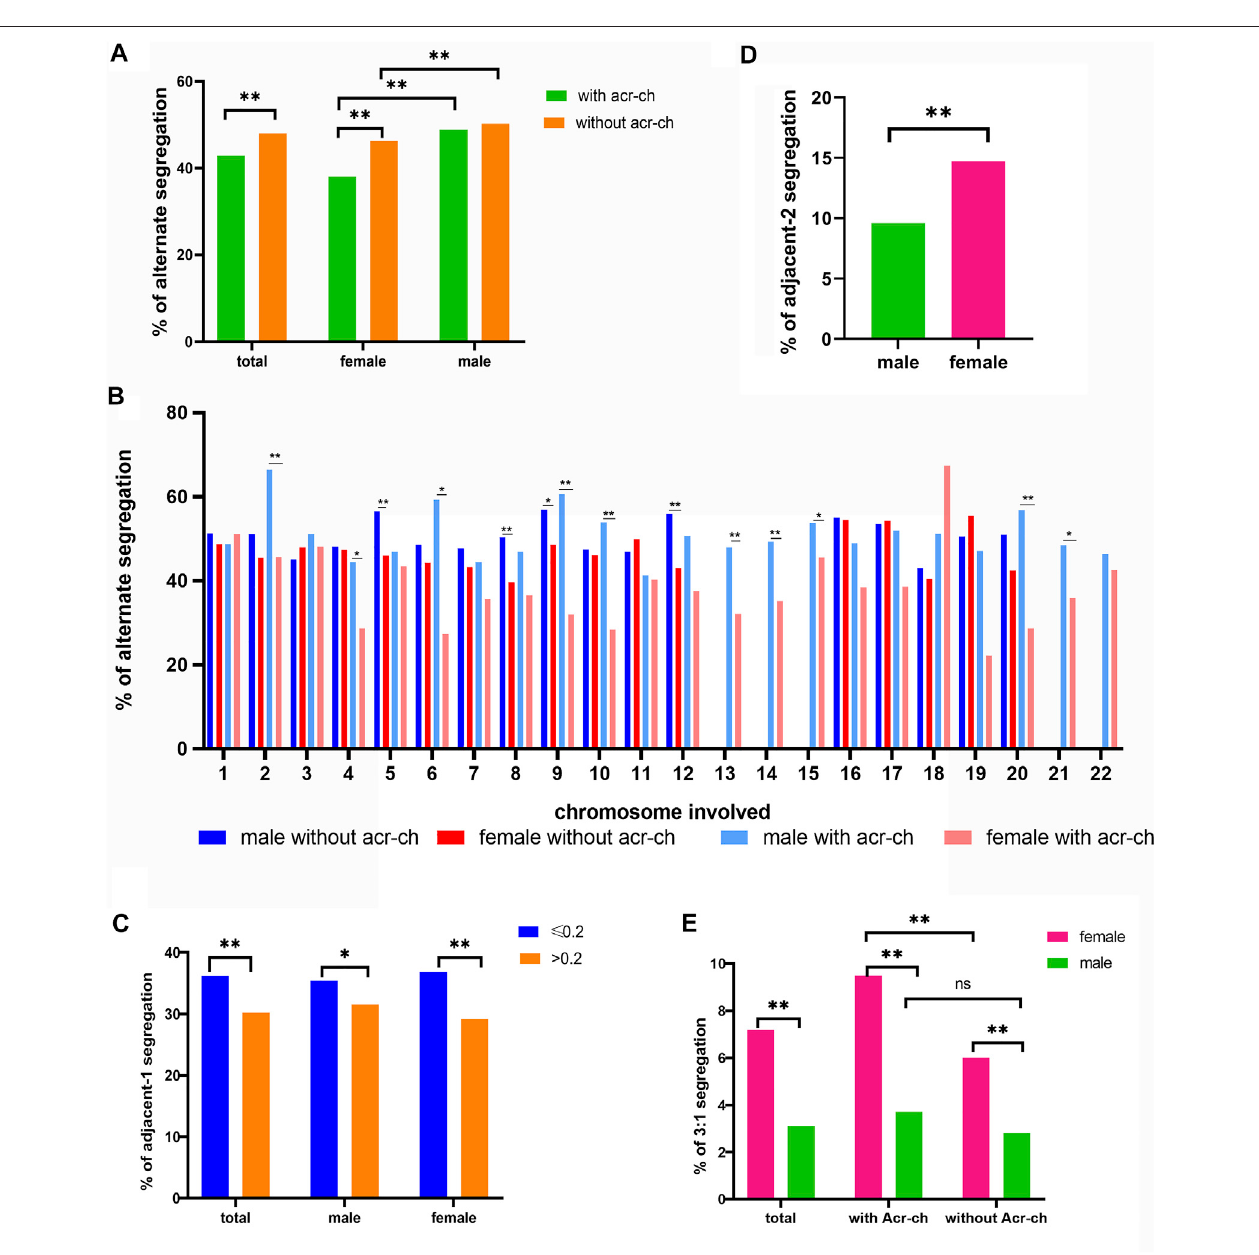
FIGURE 1 | Factors in fl uencing meiotic segregation patterns in blastocysts for reciprocal translocation carriers. (A) Alternate segregation proportions in male and female carriers according to the type of chromosome involved (Acr-ch and acrocentric chromosome). (B) Alternate segregation proportions in male and female carriers accordingtothechromosomeinvolved(Acr-ch and acrocentric chromosome). (C) Proportionofadjacent-1 segregation underdifferentvaluesofTAR1and thecarrier ’ s sex group (TAR1, the ratio of translocated segment 1 over the chromosome arm). (D) Proportion of adjacent-2 segregation in female and male carriers with reciprocal translocation. (E) Proportion of 3:1 segregation with different sex and chromosome types involved (Acr-ch and acrocentric chromosome).